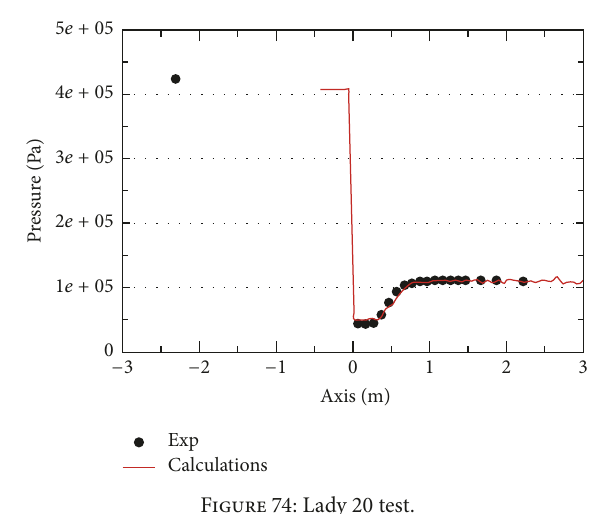
Figure 74: Lady 20 test.